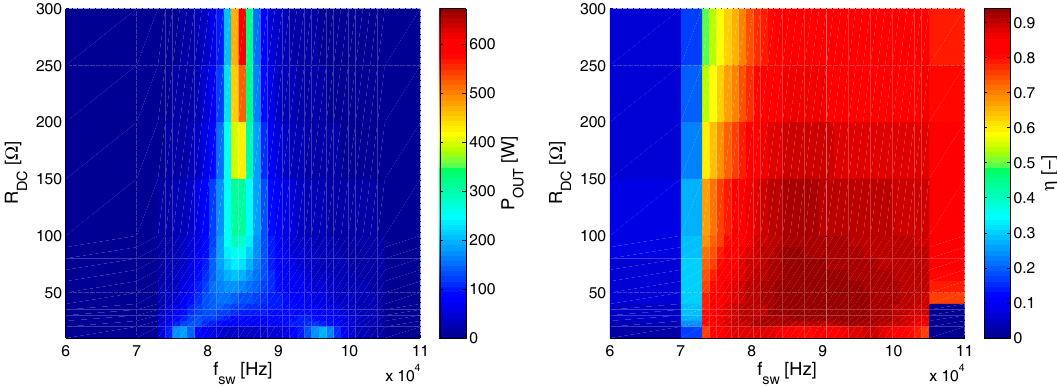
Figure 17. Power delivered to the load ( left ) and the overall efficiency ( right ) of the shielded WPT device operated with the air gap of 20 cm.